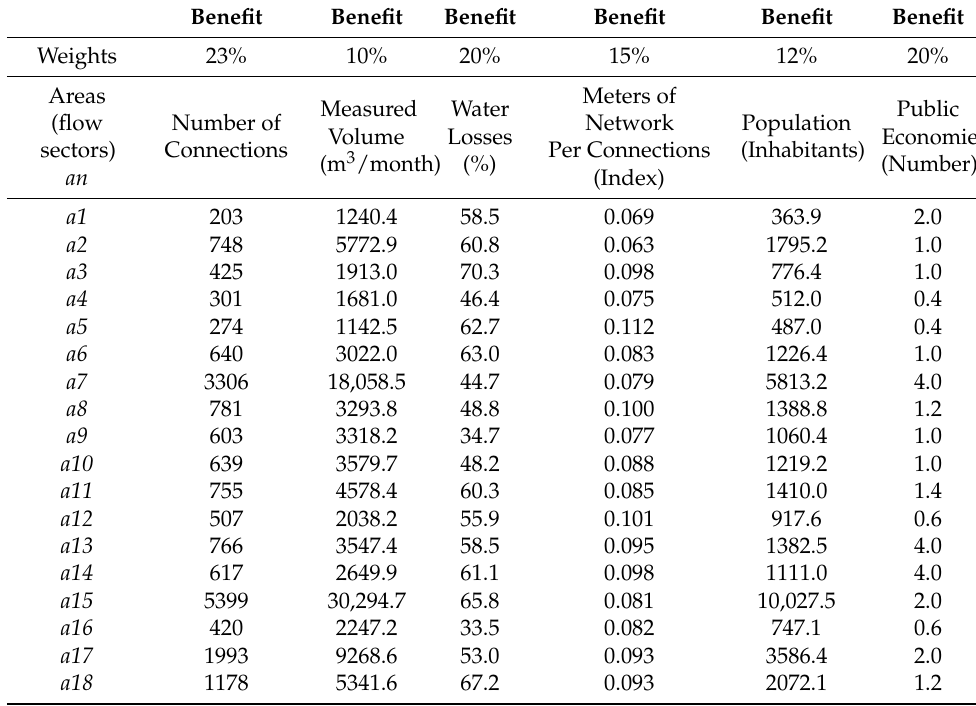
Table 6. Non-Normalized weighted dataset—Procedure